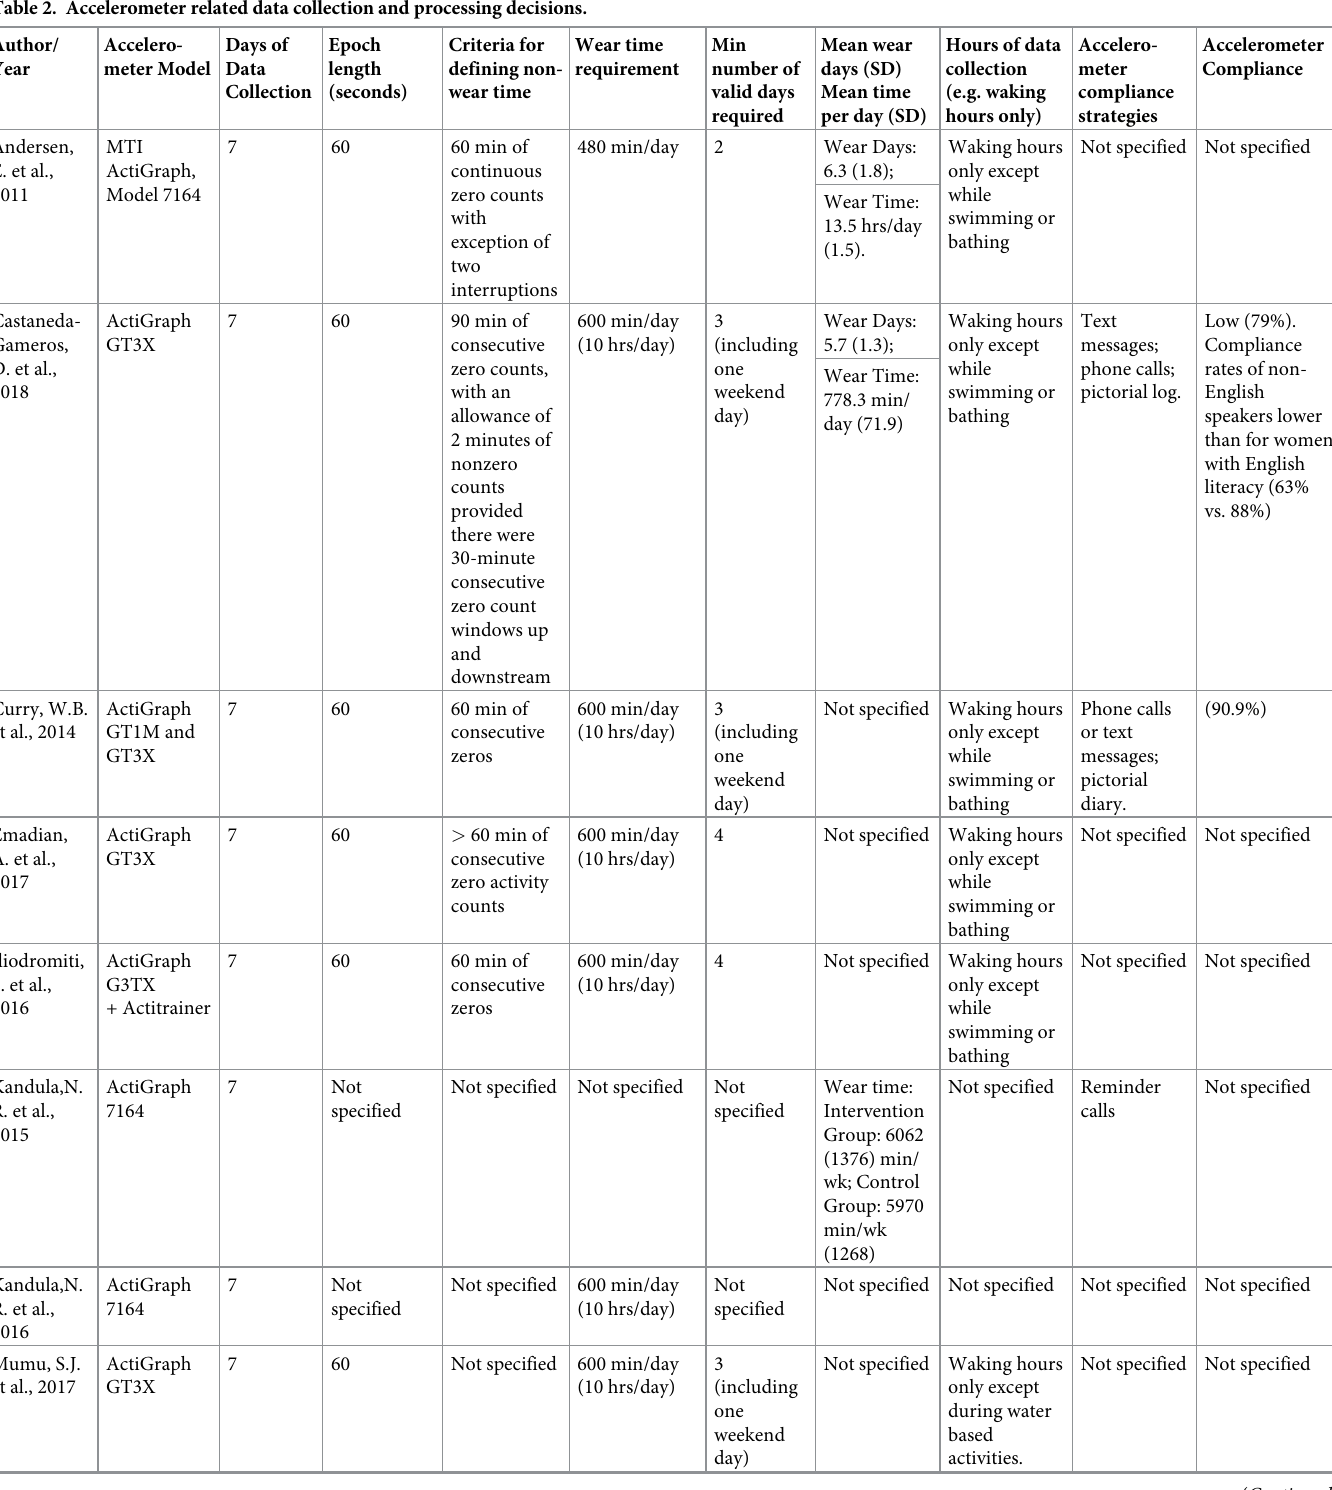
Table 2. Accelerometer related data collection and processing